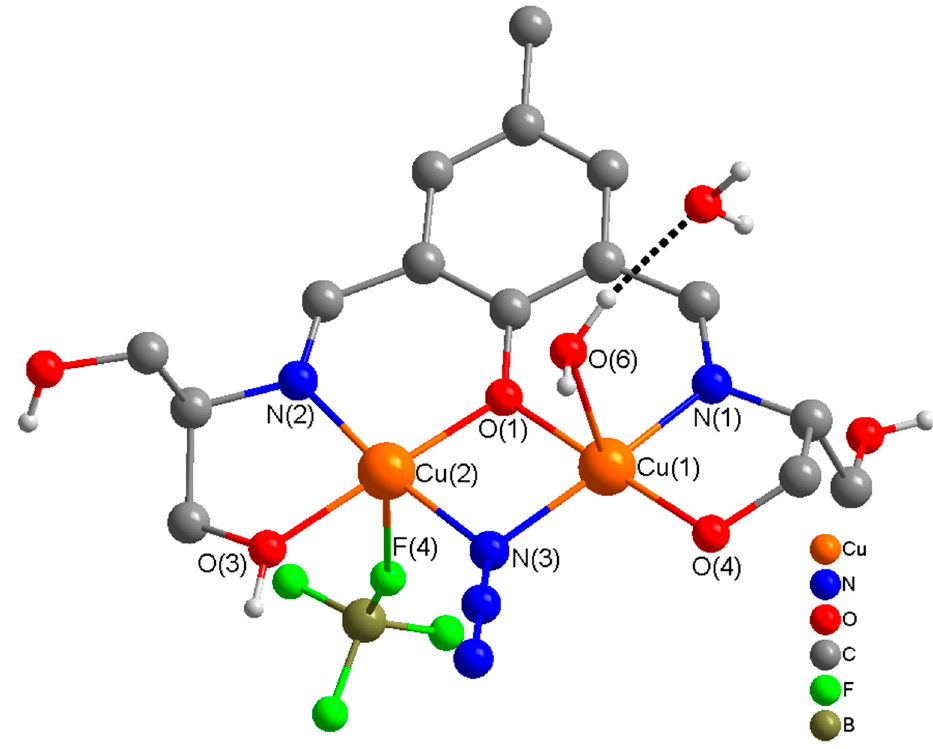
Figure 7. Molecular structure of a dinuclear unit [Cu 2 (H 3 L1 2 − )(H 2 O)(BF 4 )(N 3 )]·H 2 O in ( 4 ) with numbering of relevant atoms in the coordination environment. H-atoms are omitted for clarity.